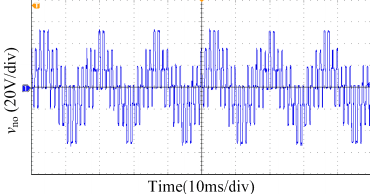
Figure 13. The common-mode voltage waveform.